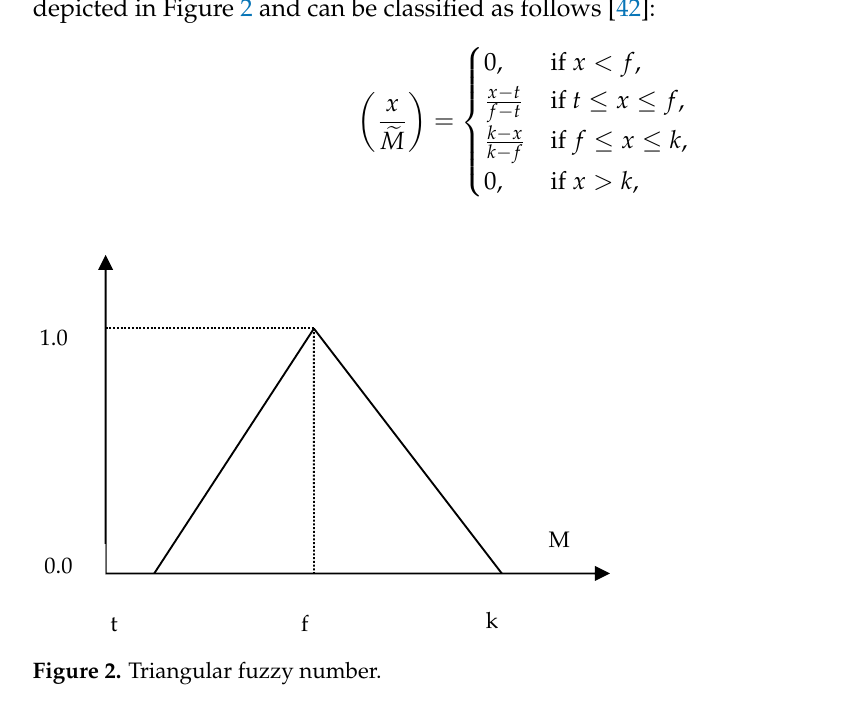
Figure 1. Research graph.